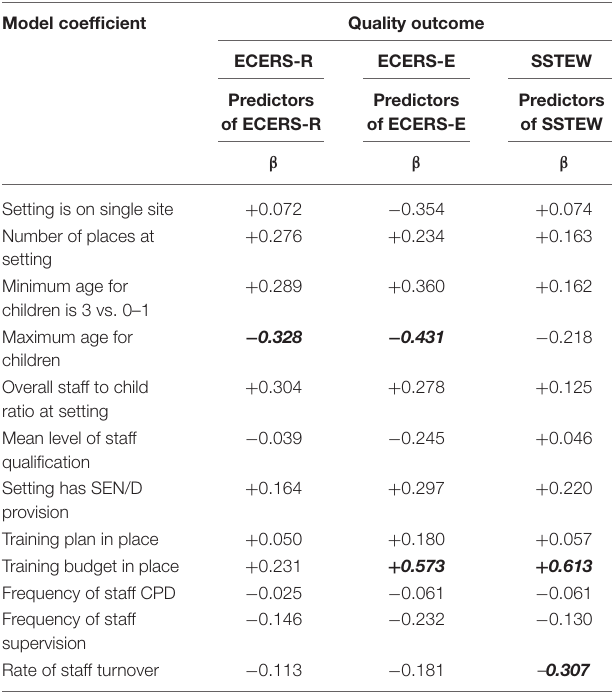
TABLE 6 | Results of regression models of quality in terms of structural characteristics; nursery classes/schools. Model coefficient